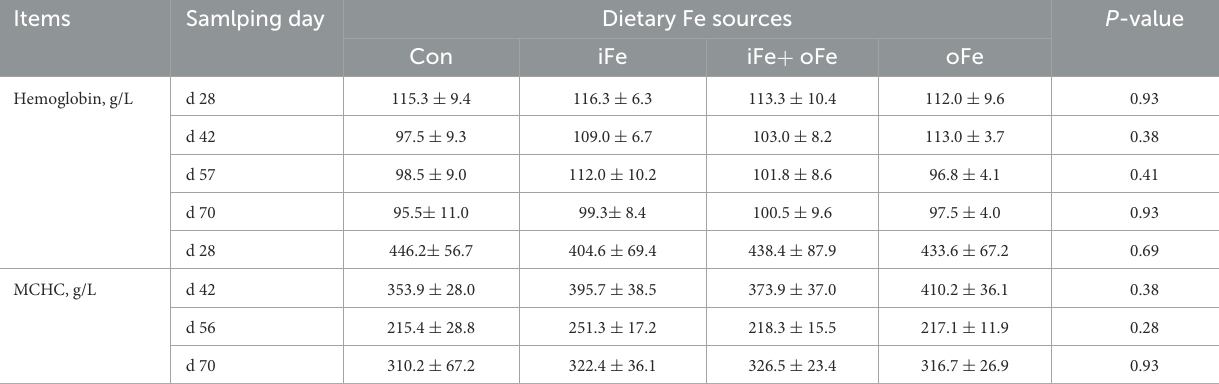
TABLE 4 Effects of different dietary iron sources on hemoglobin and MCHC levels of weaned piglets from d 28 to d 70.